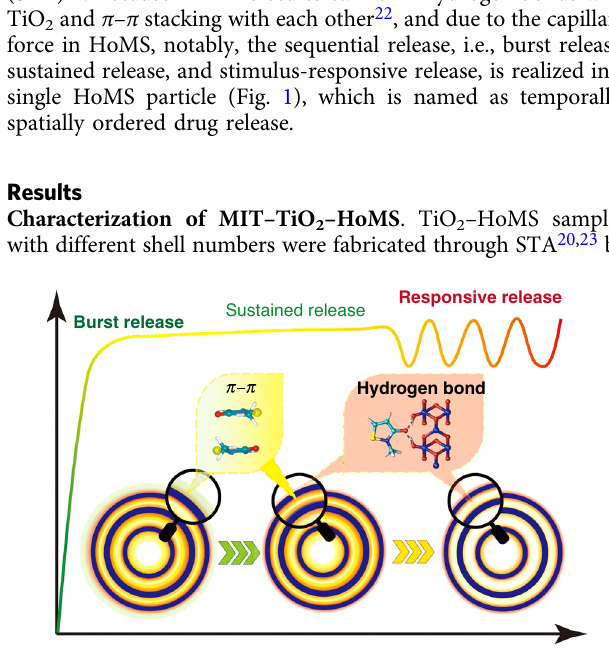
Fig. 1 Schematic illustration of the spatially dependent drug release by HoMS. The green part represents drug molecules adsorbed on the outer surface of TiO 2 – HoMS, which are easily released at the initial stage, resulting in burst release; the yellow part represents drug molecules in the cavity, which interact through π – π interactions, which contribute not only to the sustained release stage but also more to the responsive release stage; the red part represents drug molecules that form hydrogen bonds with the TiO 2 surface, which also contribute to part of the responsive